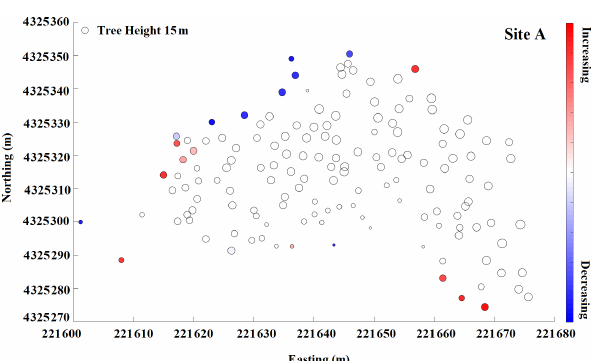
Figure B4. Snow depth change within a 10m buffer from the edge of a tree at site A. Red color indicates snow depth increases moving from the tree edge toward the open areas, and blue indicates snow depth decreases. Increasing and decreasing patterns are shown for individual trees at each site with adequate snow coverage.